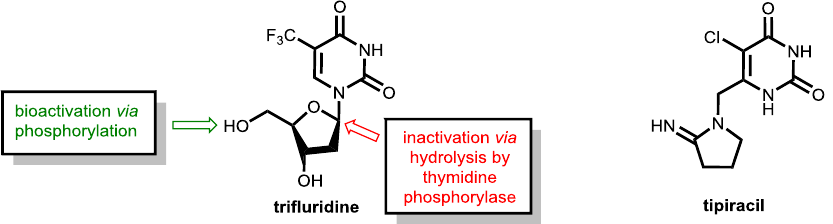
Figure 21. ( Left ) Structures of the antimetabolite trifluridine and its sites of bioactivation (green) and degradation (red). ( Right ) The thymidine phosphorylase inhibitor tipiracil.